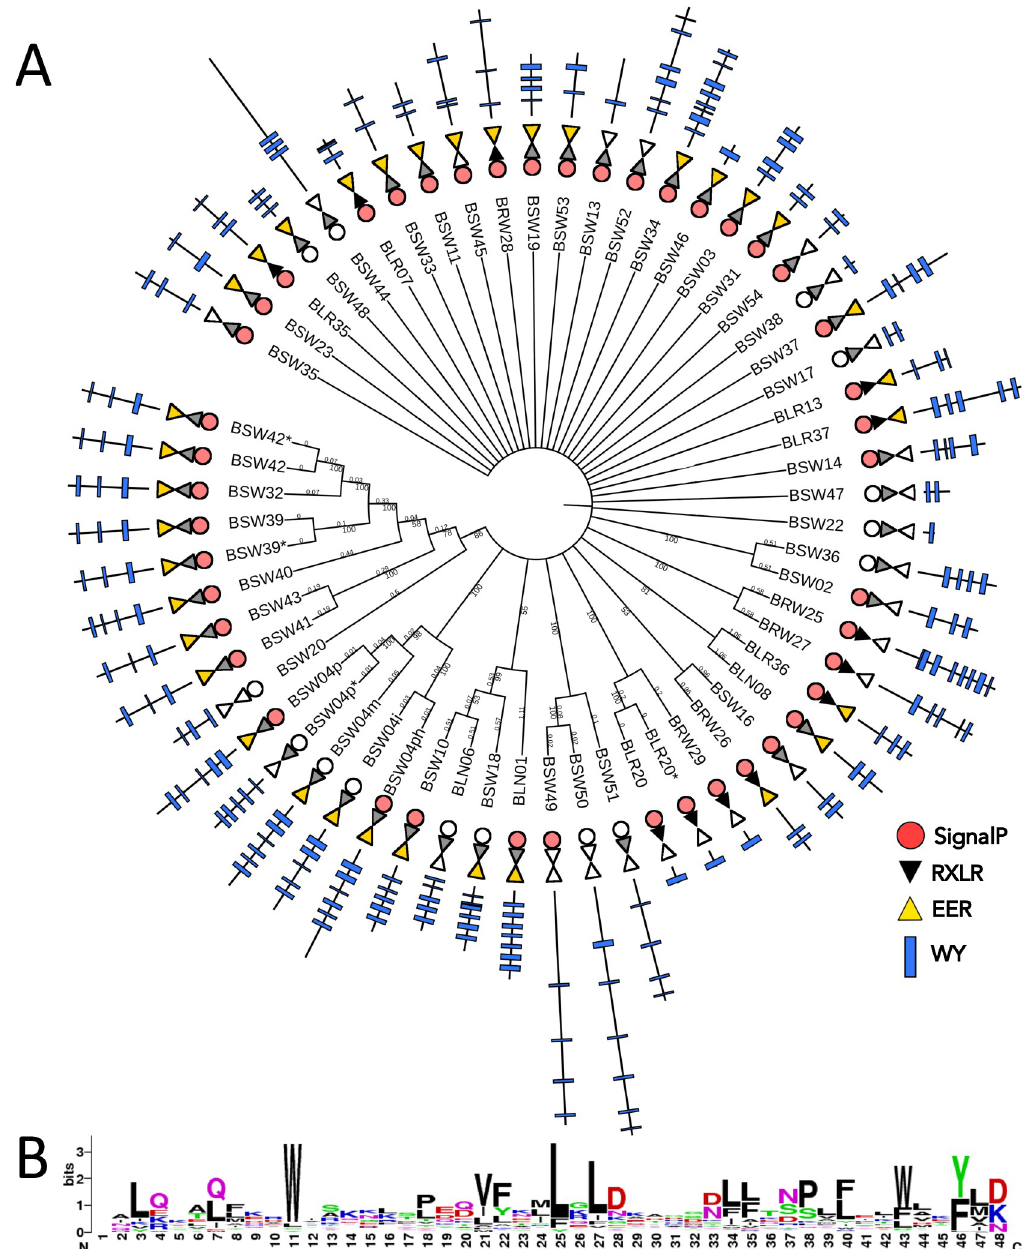
Fig 1. WY effector candidates from B . lactucae isolate SF5. (A) UPGMA consensus tree of the 59 predicted WY effectors from B . lactucae isolate SF5 based on whole protein amino acid sequence alignment using MUSCLE. Four sequences that appear to be allelic are indicated with asterisks next to the sequence name. Branch lengths have been transformed for clarity of presentation; however, bootstrap values (n = 100 iterations) and branch lengths are given for closely related proteins. Signal peptides are shown as circles (red circle for SP; white circle for no SP). RXLR motifs are shown as triangles (black triangle for RXLR ([RQGH]XLR or RXL[QKG]); grey triangle for degenerate RXLR ([RKHGQ][X]{0,1}[LMYFIV][RNK]), white triangle for no RXLR-like sequence) followed by an inverted triangle for EER motifs (yellow triangle for [DE][DE][RK], white triangle for no EER-like sequence). WY domain architecture is shown using blue rectangles, with a black line representing the total length of the protein and rectangle position representing the location of the WY motif as predicted by HMMer 3.1. (B) Sequence logo for the WY domain from B . lactucae built from a multiple sequence alignment of WY domains predicted by HMMer